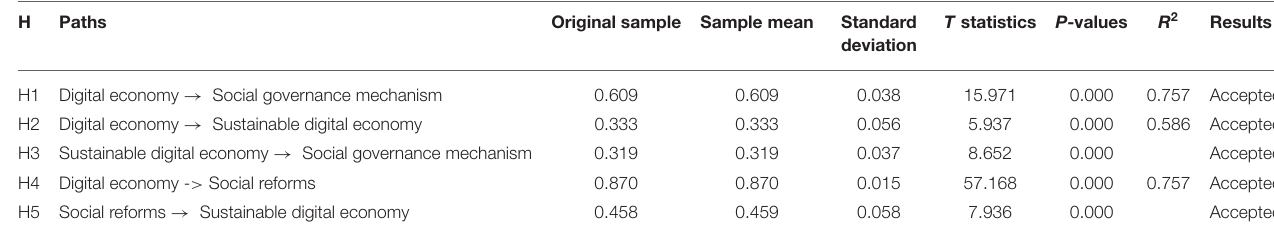
TABLE 5 | Direct effects. H